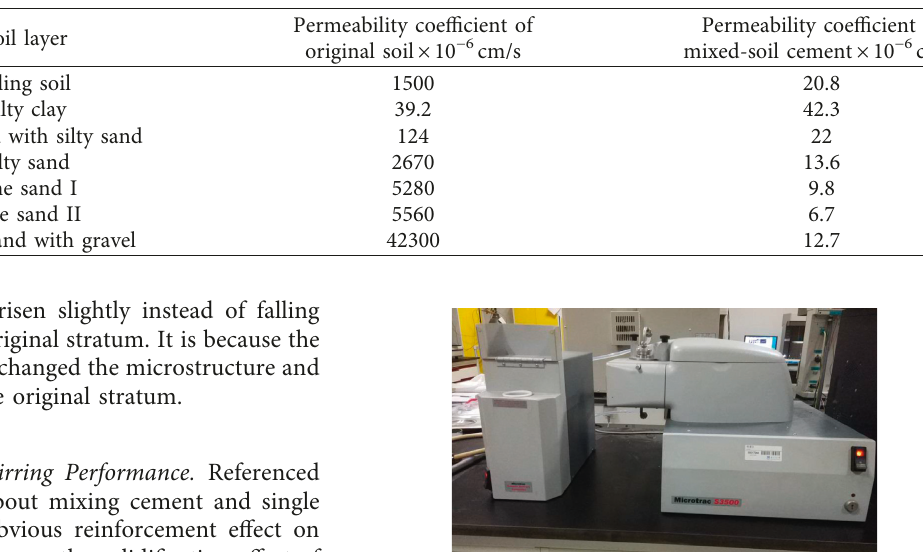
Table 4: Permeability coefficient of cement-mixed soil.